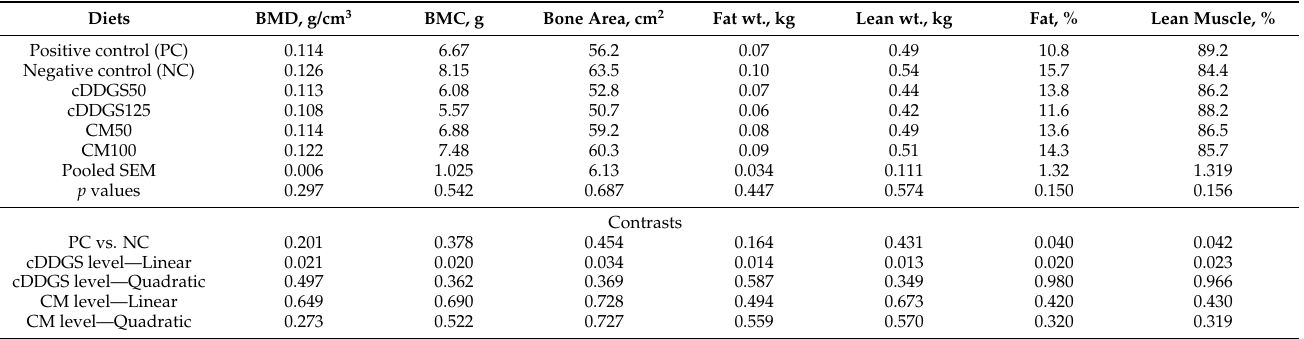
Table 9. Whole body composition (d 21) of broilers receiving diets containing soybean with reduction in crude protein or low-protein diets with serial inclusion levels of canola meal or corn–DDGS supplemented with crystalline amino acids.